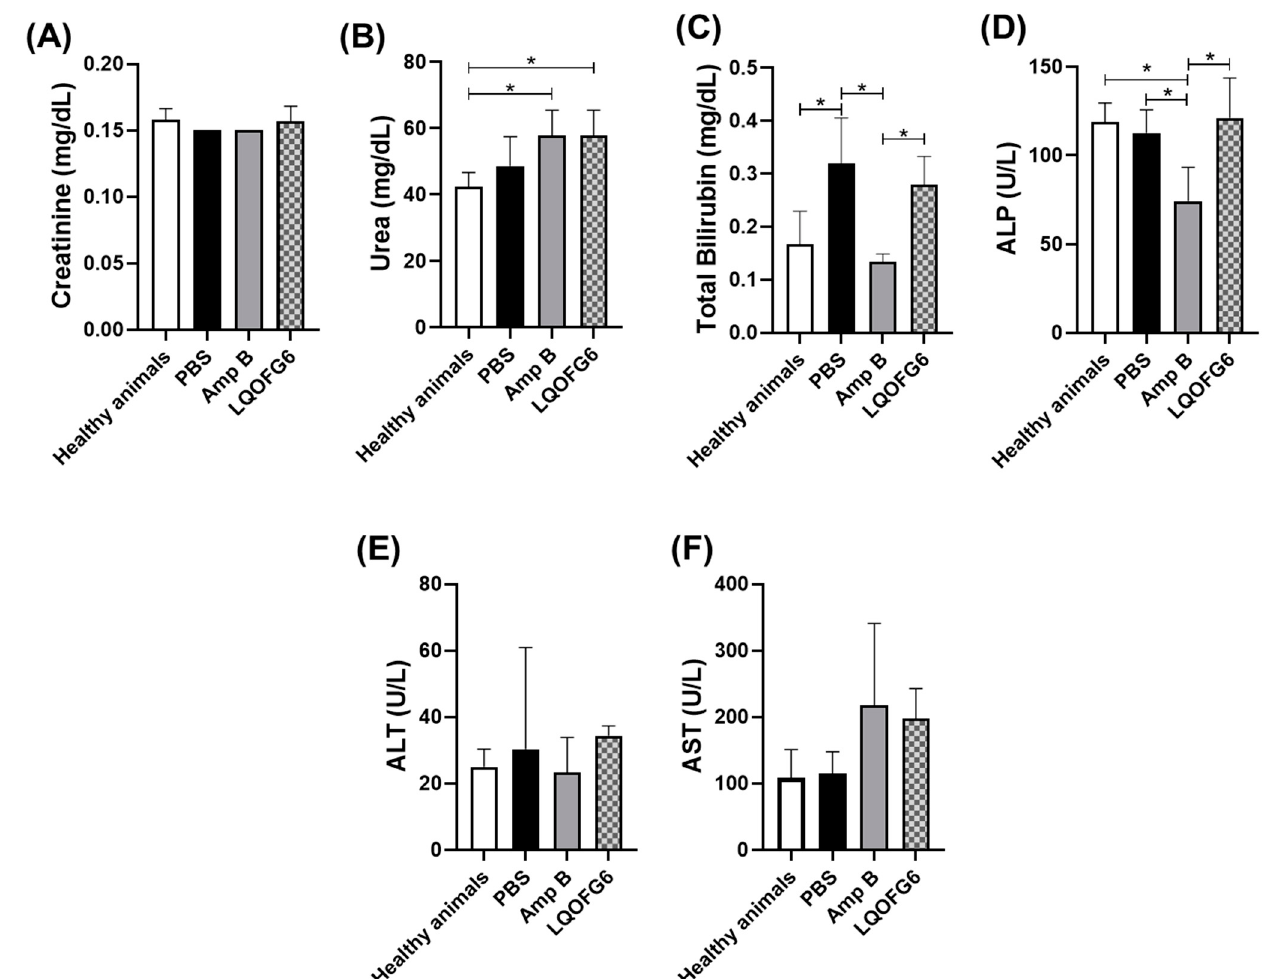
Figure 7. Plasma levels of biomarkers related to hepatic and renal functions in healthy (noninfected) BALB/c mice and animals infected with L. amazonensis and treated with either 1X PBS (vehicle control), 2.0 mg/kg/day LQOF-G6 or 2.0 mg/kg/day Amp B. ( A ) Creatinine levels; ( B ) Urea levels; ( C ) Total bilirubin levels; ( D ) ALP levels; ( E ) ALT levels: ( F ) AST levels. The data are expressed as averages plus SD. * Statistically significant difference between groups ( p < 0.05).